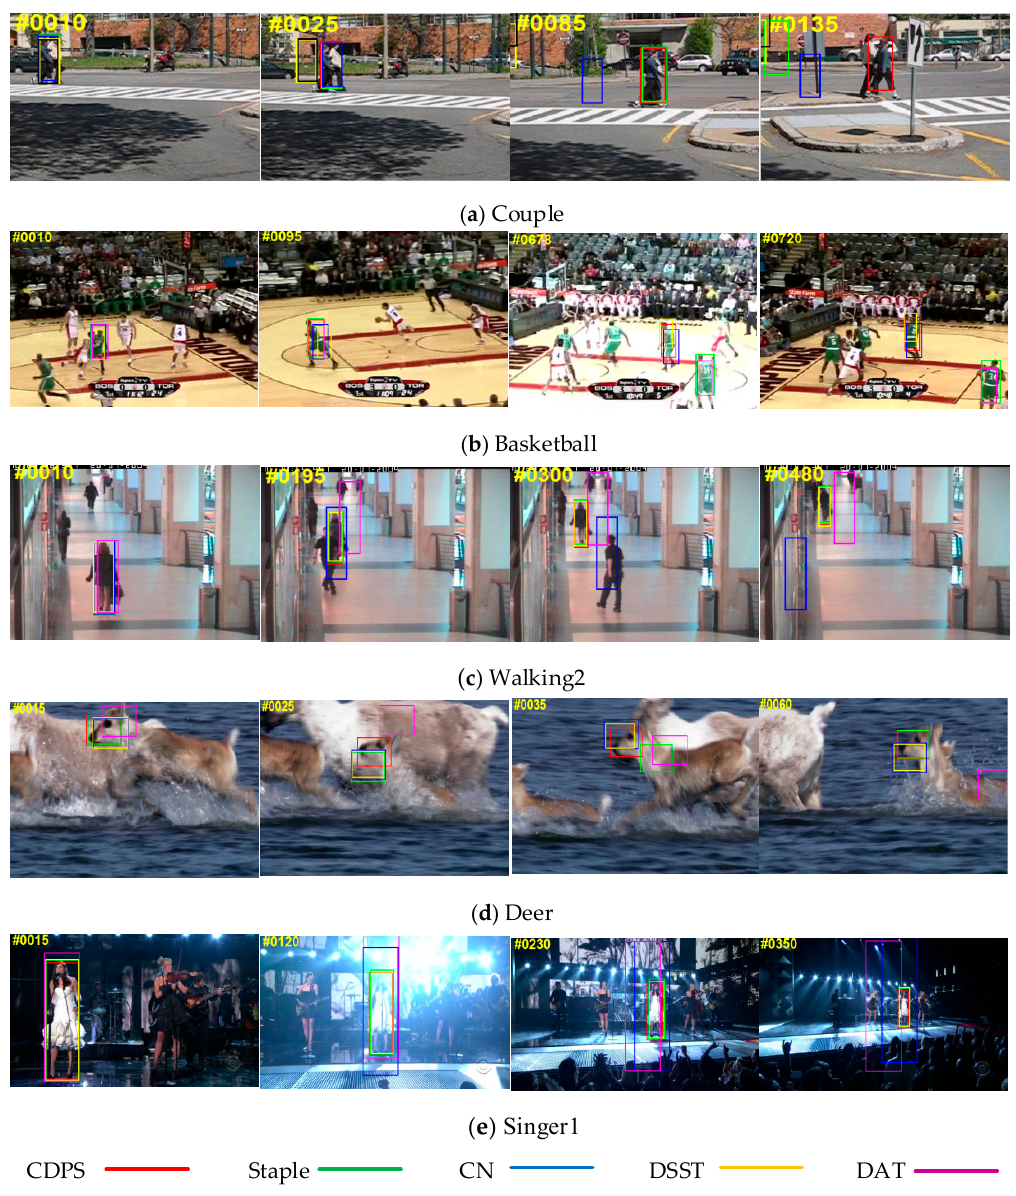
Figure 3. A comparison of our approach with the state-of-the-art trackers Staple, CN, DSST, and DAT. The example frames are from the “Couple”, “Basketball”, “Walking2”, “Deer”, and “Singer1” sequences, respectively. The results of Staple [21], CN [15], DSST [9], DAT [16], and our approach are represented by green, blue, yellow, pink, and red boxes,